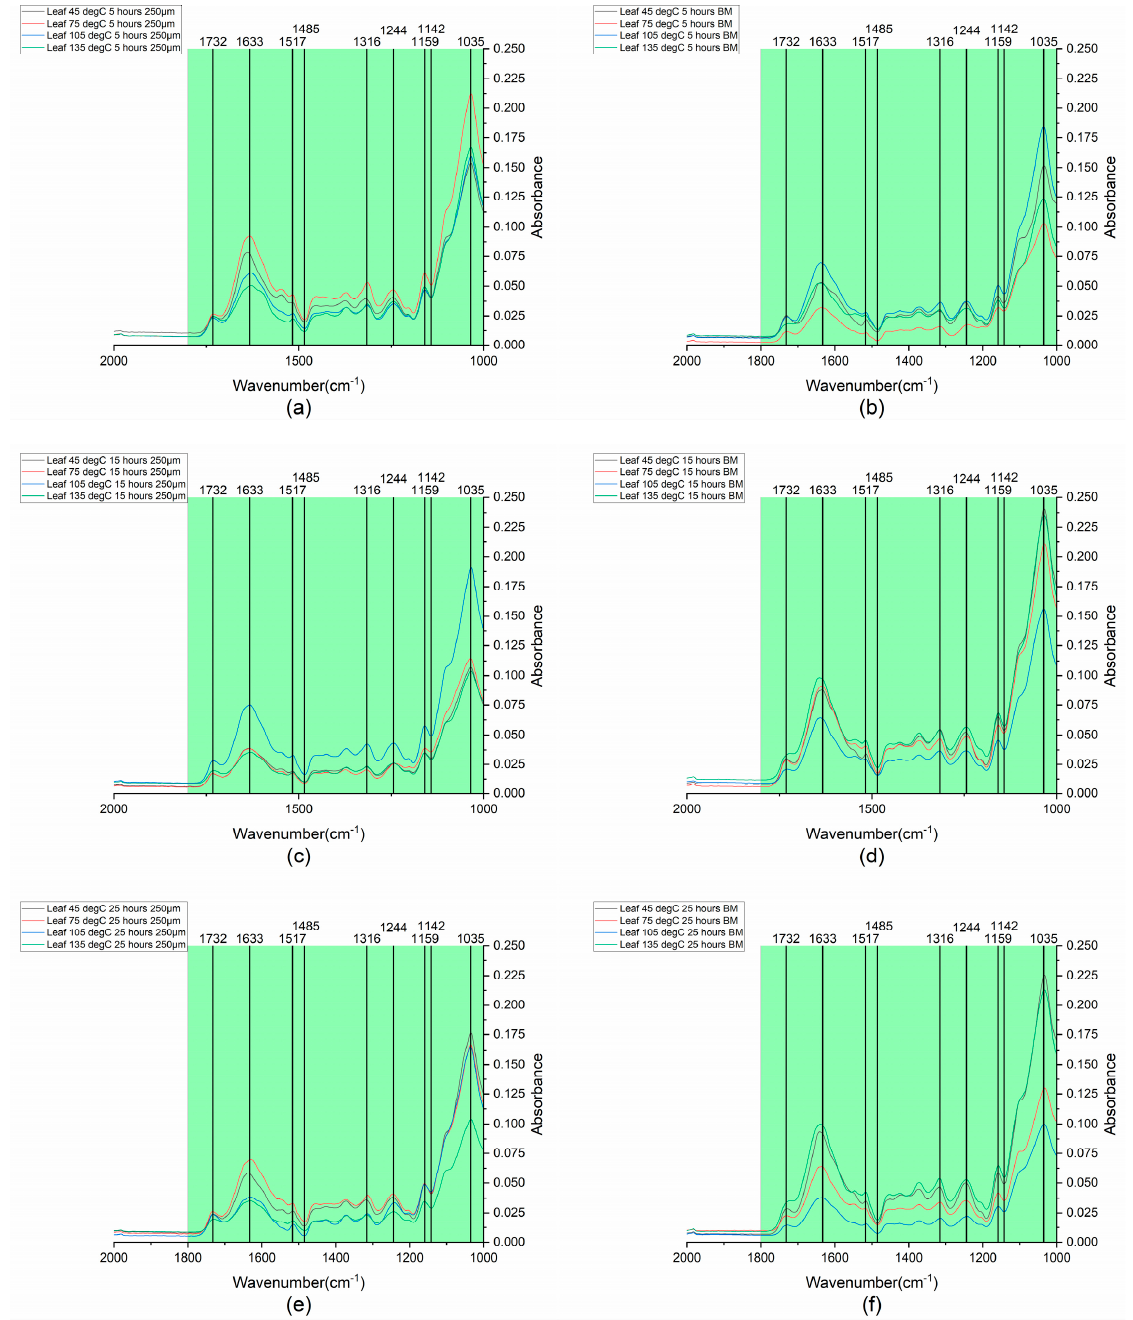
Figure 2. FTIR spectra for leaf particles at varying sizes, times, and temperatures; ( a ) 250 µ m for 5 h, ( b ) 250 µ m for 15 h, ( c ) 250 µ m for 25 h, ( d ) ball-milled for 5 h, € ball-milled for 15 h and ( f ) ball-milled for 25 h.